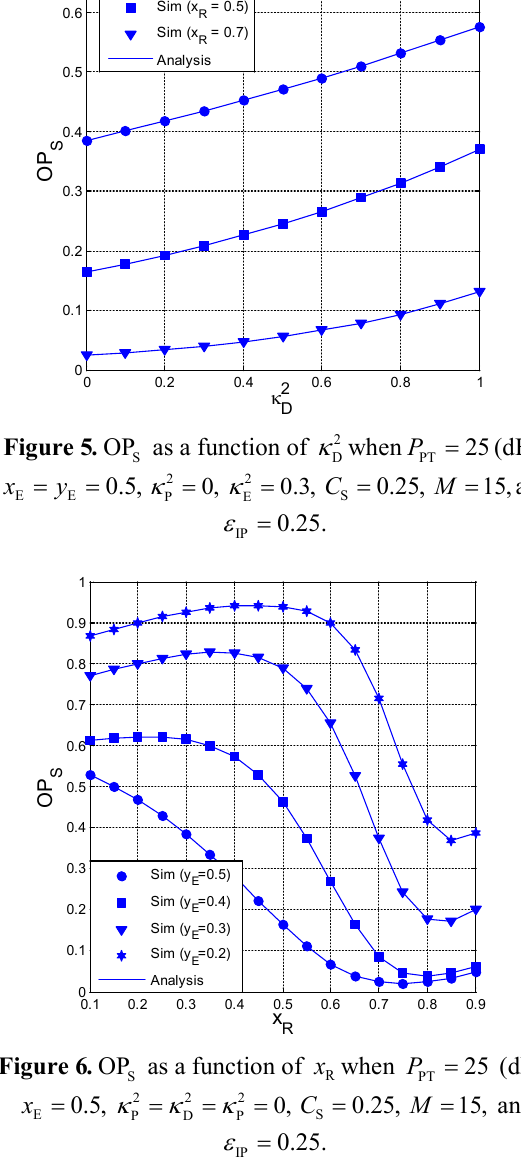
OP as a function of S